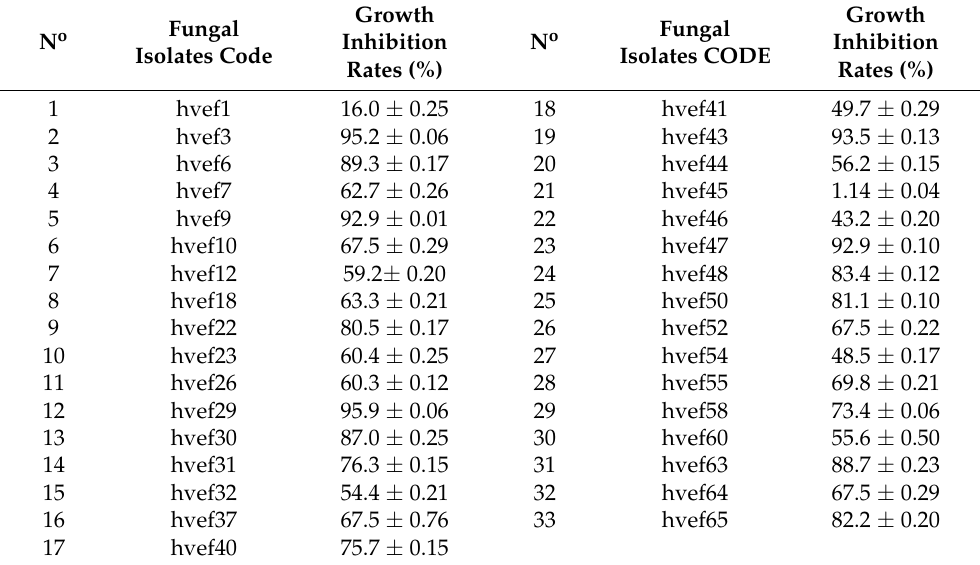
Table 3. Inhibitory potential of isolated fungal endophytes against Calonectria ilicicola .